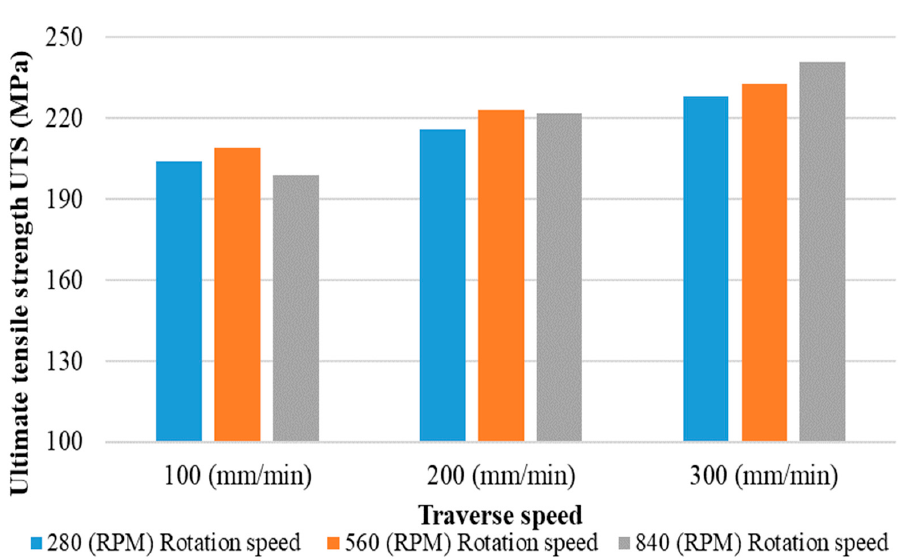
Figure 14. Ultimate tensile strength for the dissimilar Al joint with traverse and rotation speeds of the tool in FSW [76]